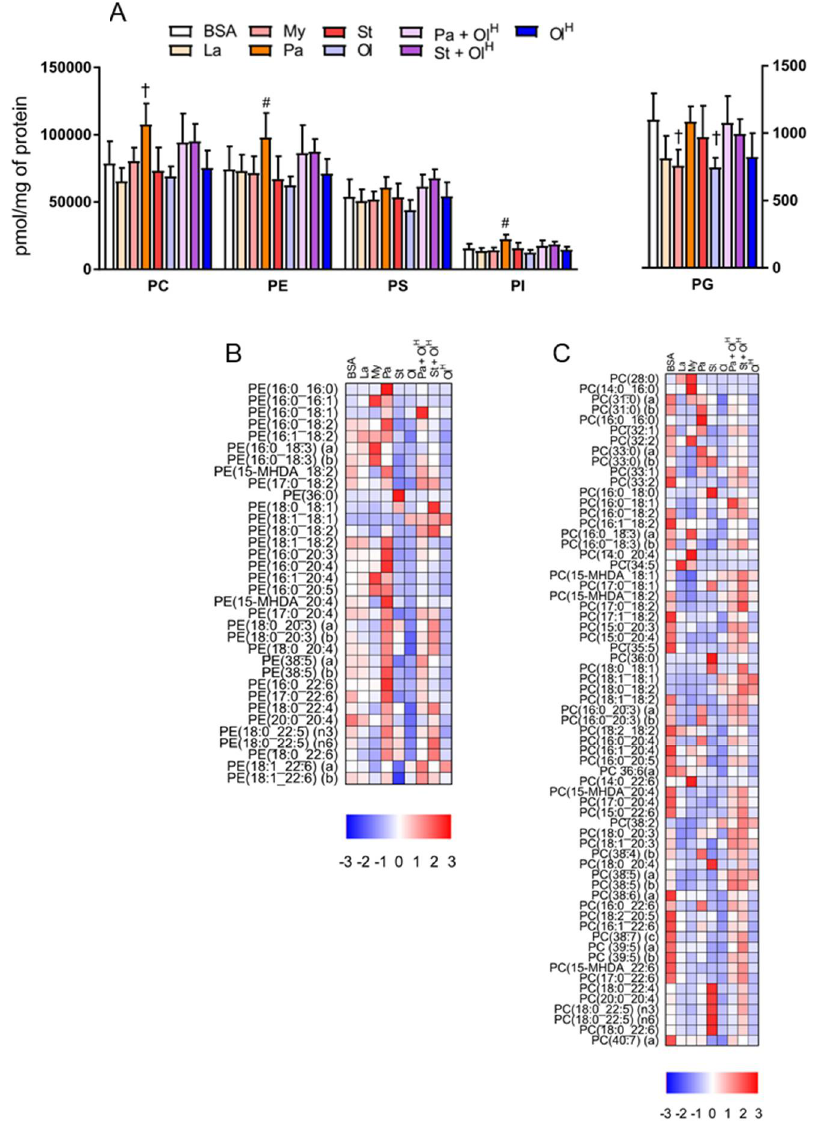
Figure 4. The effects of fatty acids on phospholipids. ( A ) Concentrations of total phosphatidylcholine (PC), phosphatidylethanolamine (PE), phosphatidylserine (PS), phosphatidylinositol (PI) and phosphatidylglycerol (PG) in BMDM treated with the indicated fatty acids. Data in A are the mean + SD. Symbols represent statistical significance compared with BSA at the following α levels: † p ≤ 0.01; # p ≤ 0.05. Heat maps showing the indicated lipid species within PE ( B ) and PC ( C ) in BMDM treated with the indicated fatty acids. Data are presented as Z-score by column. Data are from 6 independent mice.